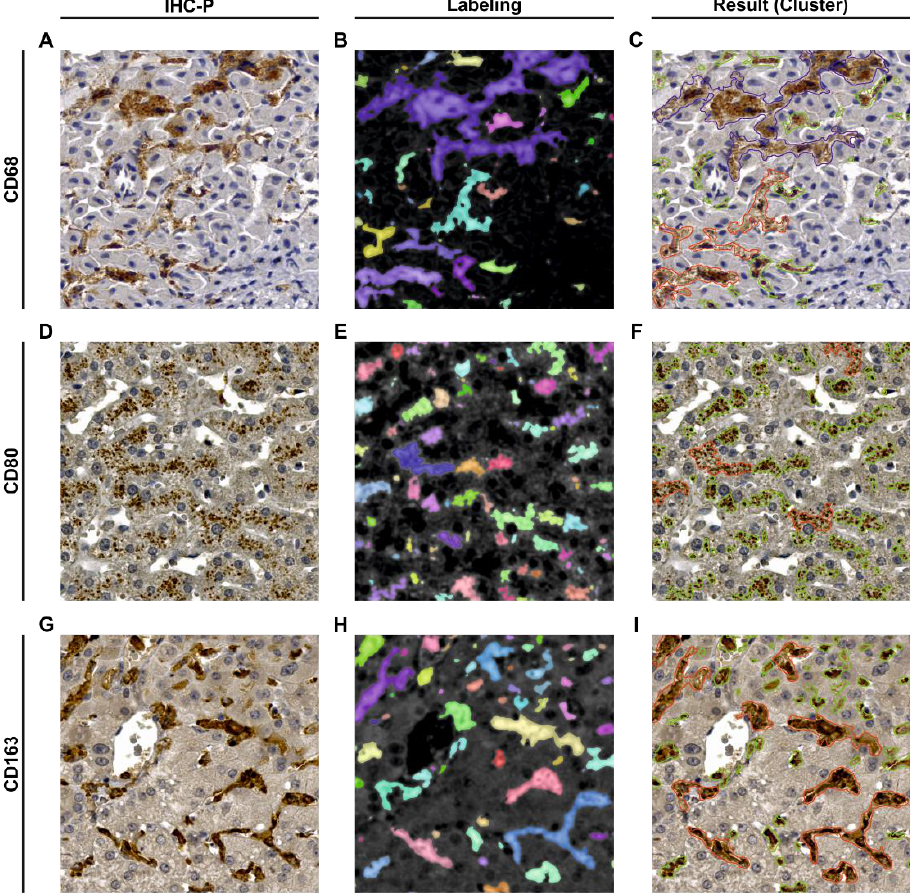
Figure 2. Visualization of the input, the intermediate step of labeling, and the output of the macrophage segmentation method. The first column of images ( A , D , G ) corresponds to original RGB images. The middle column of images ( B , E , H ) show gaussian filtered versions of the output mask I4 of labeled feature regions. Here, the different colors represent the resulting individual objects consisting of labeled pixels which in turn correspond to the macrophages. The third column of images ( C , F , I ) visualizes the clustered feature regions (green: Cluster 1 from 10–300 µm 2 ; red: Cluster 2 from 300.01–2000 µm 2 ; blue: Cluster 3 with >2000.01 µm 2 ). A – C : Donor D09 (Tile: s1_m0127); D – F : Donor